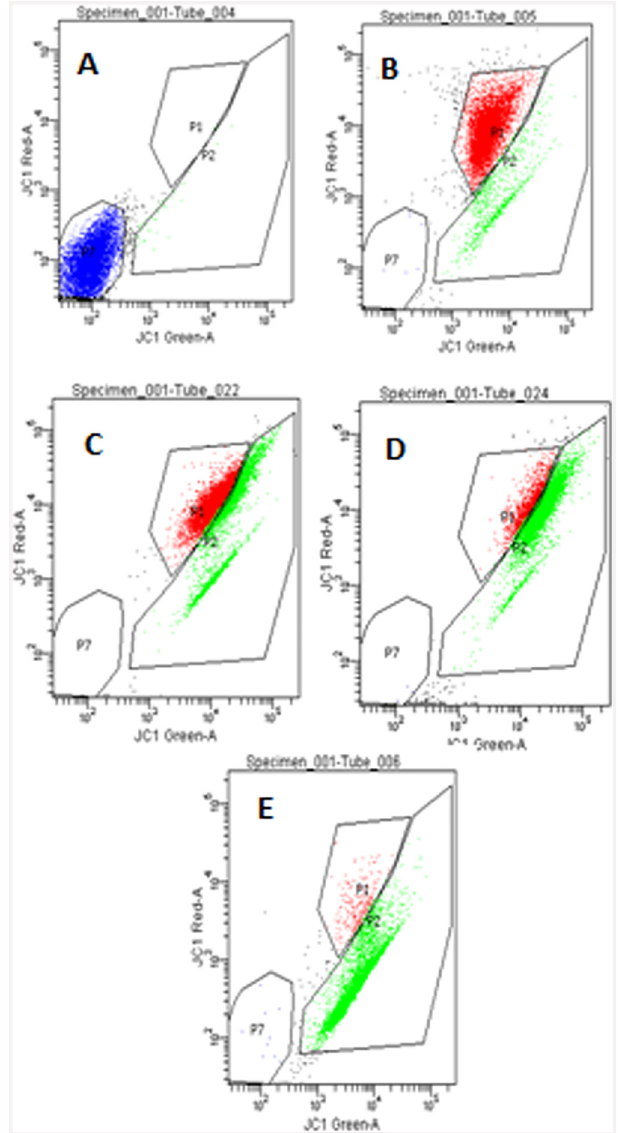
Fig 16. Induction of mitochondrial membrane depolarization in HeLa cells treated with various concentrations of ‘ fungal VCR ’ . A — cells alone, B — cells + JC1 stain, C — cells + JC1 + 25 μ M valinomycin (+ ve control), D — cells + JC1 + fungal VCR (5 μ g/ml), E — cells + JC1 + fungal VCR (10 μ g/ml), F — cells + JC1 + fungal VCR (25 μ g/ml), G — standard VCR (2 nM) and H — percent loss of mitochondrial membrane